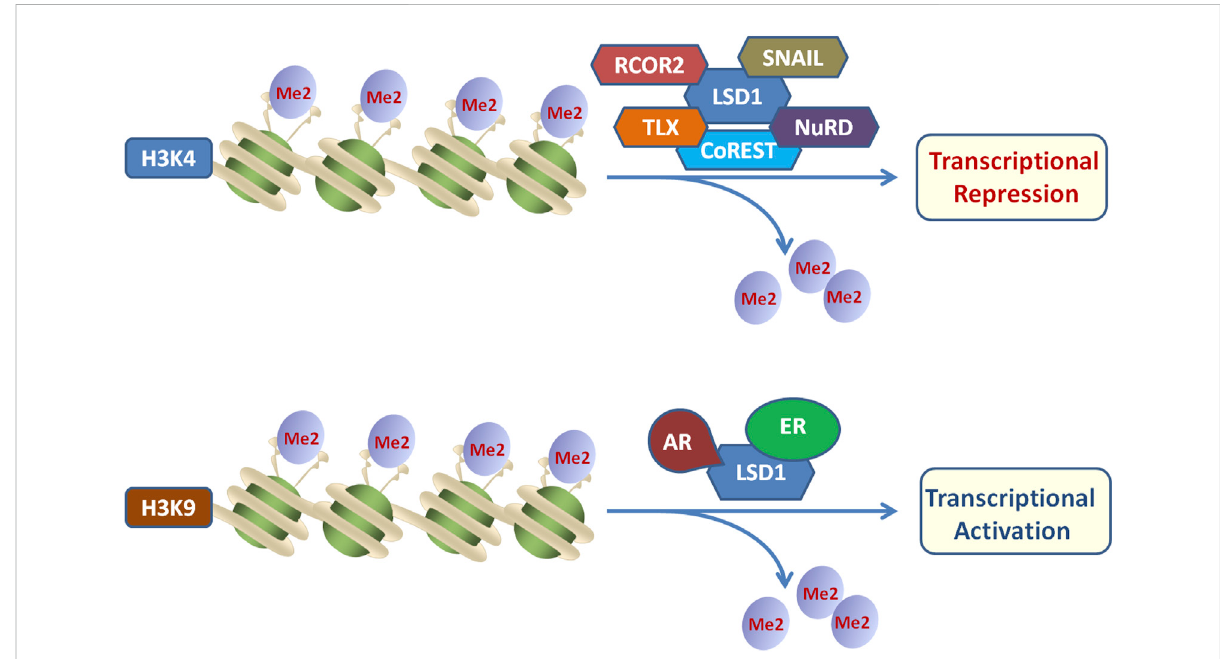
FIGURE 3 Dual functions of LSD1 as transcriptional repressor or activator by binding distinct